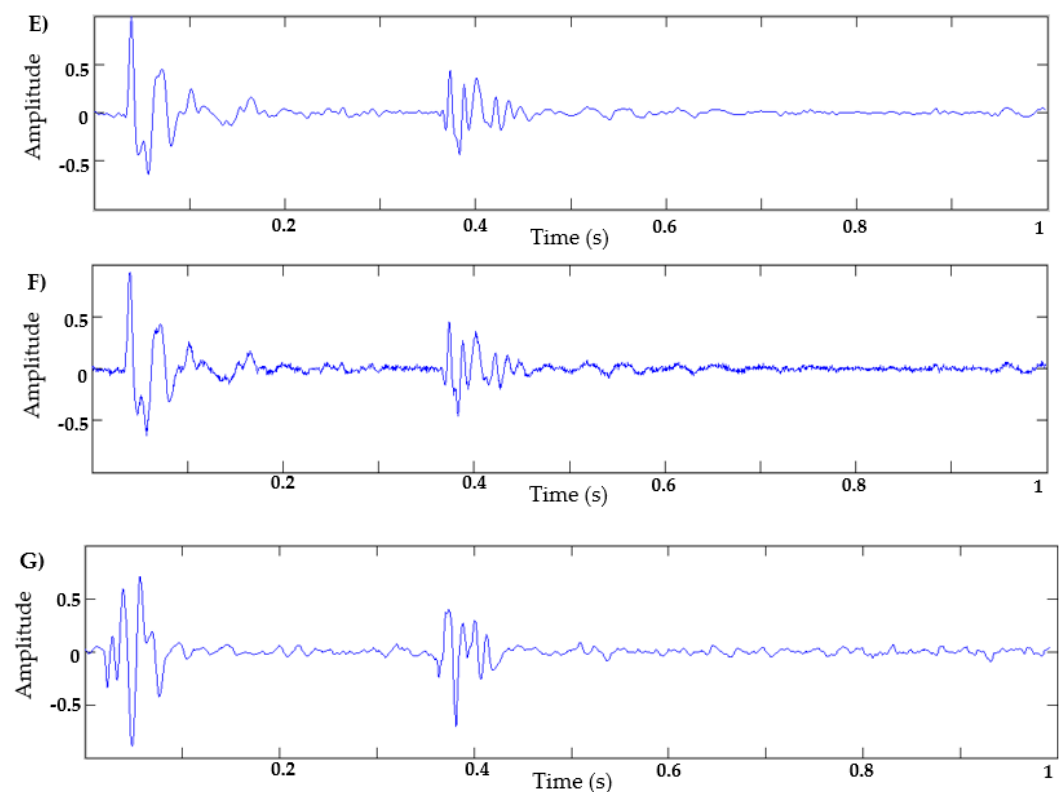
Figure 8. ( A ) Synthetic signal with 100 epochs, ( B ) synthetic signal with 500 epochs, ( C ) synthetic signal with 1000 epochs, ( D ) synthetic signal with 2000 epochs, ( E ) synthetic signal with 2000 epochs + EWT, ( F ) synthetic signal with 12,000 epochs, and ( G ) natural signal of heart sound.